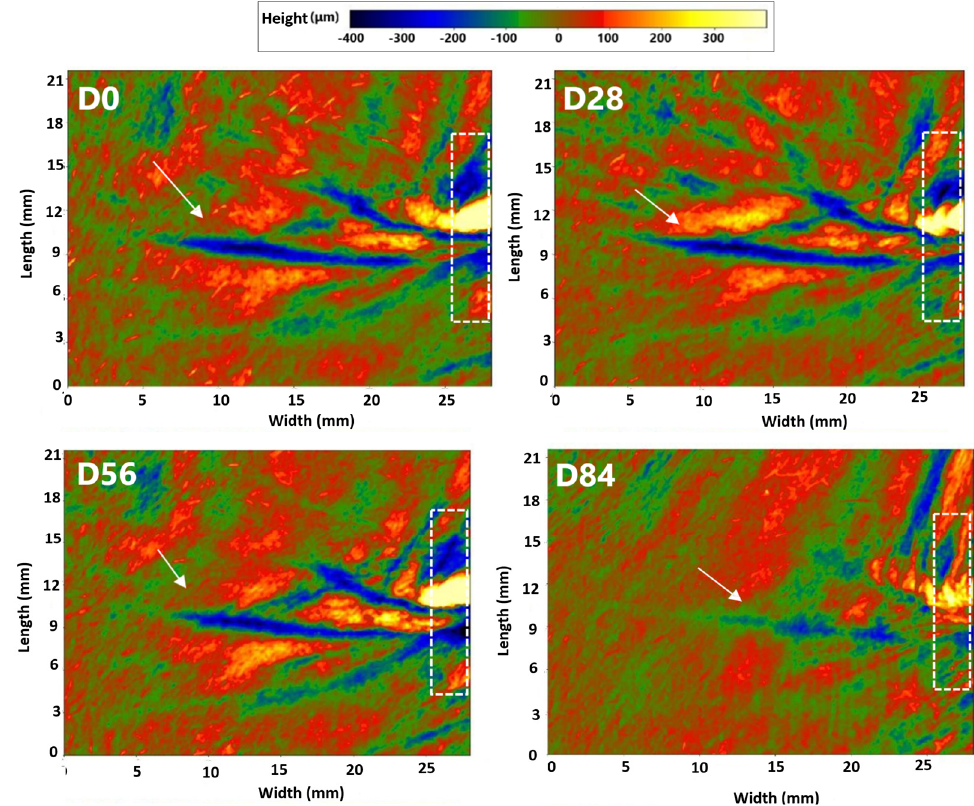
Figure 4. Periocular wrinkles were evaluated with Primos CR in one volunteer in the EY treatment group. The skin surface is red in color (value approximatively by 0 mm (according to the color scale present in the upper part of the figure). Green and blue colors represent negative values, indicating the presence of wrinkles. Orange and yellow colors represent values higher than zero.. Wrinkle is marked by the white arrow. Eye corner, which is acquired as a reference, is marked by the dotted line box. Table 3. Effects on radiance and dark spots